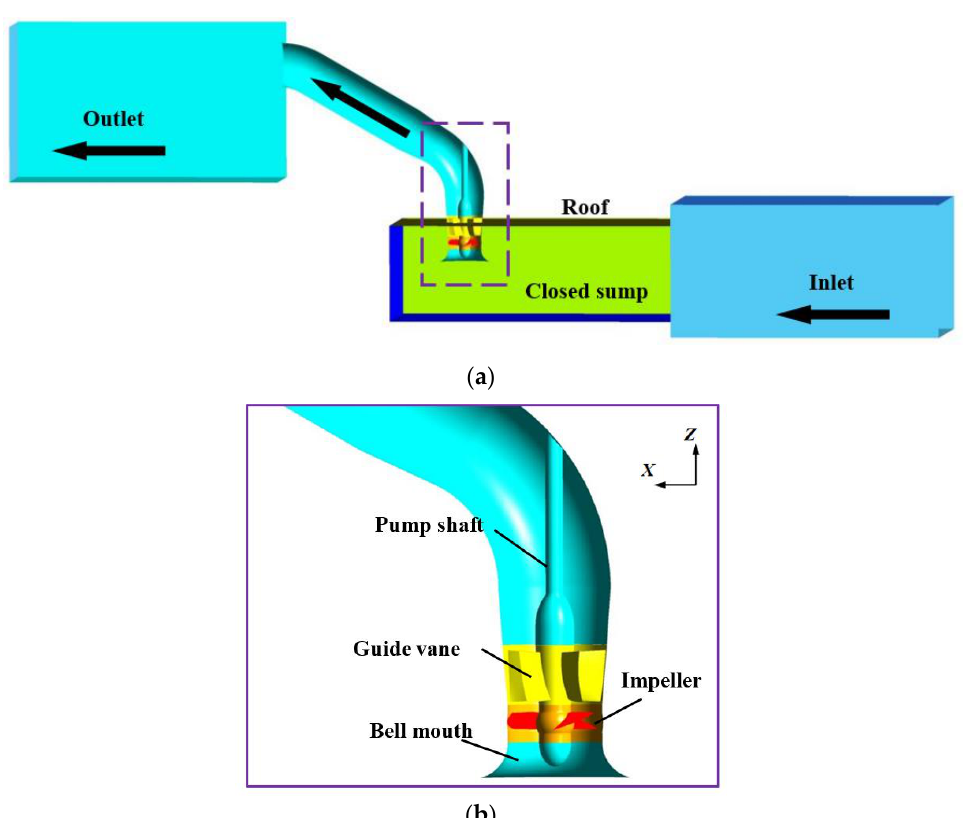
Figure 2. Simulation domain of the closed sump. ( a ) Integral calculation model of the closed sump. ( b ) Pump section model.